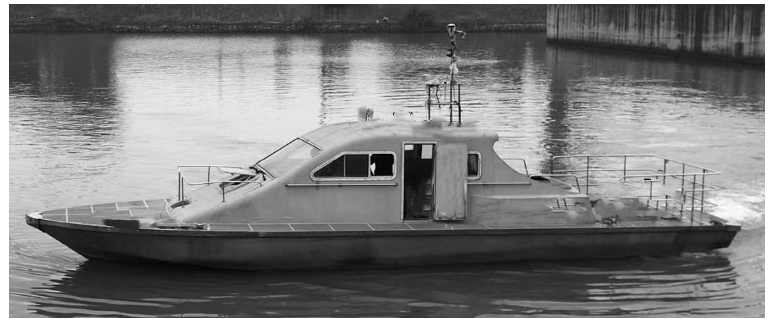
Figure 1. The considered twin-waterjet propelled vessel in the